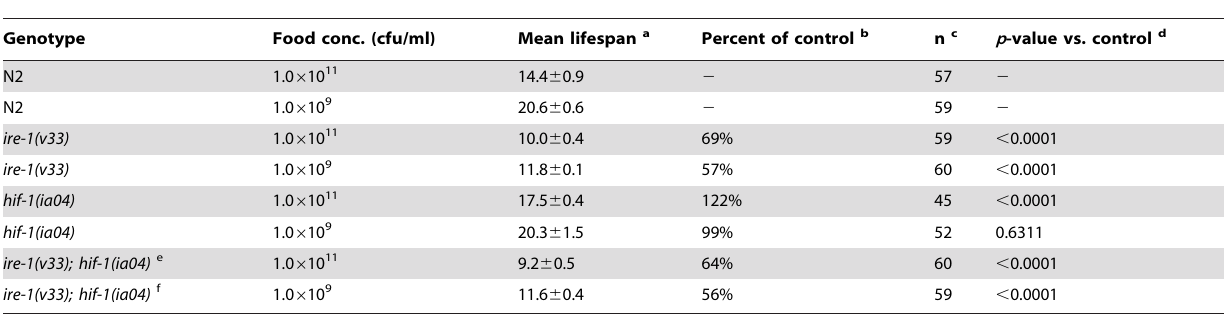
Table 4. IRE-1 is required for lifespan extension by hif-1 .